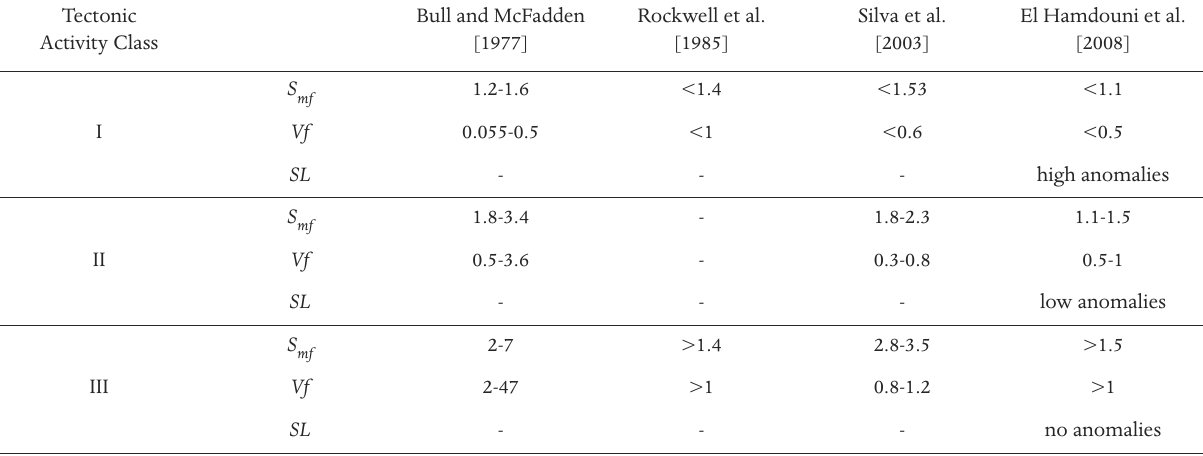
Table 1. Overview of tectonic activity classes compiled by Bull and McFadden [1977], Rockwell et al. [1985], Silva et al. [2003], El Hamdouni et al. [2008]. These ranges are used to classify each value of geomorphic indices in Table 2 and to conclude on a tectonic activity class for each of the three segments of the